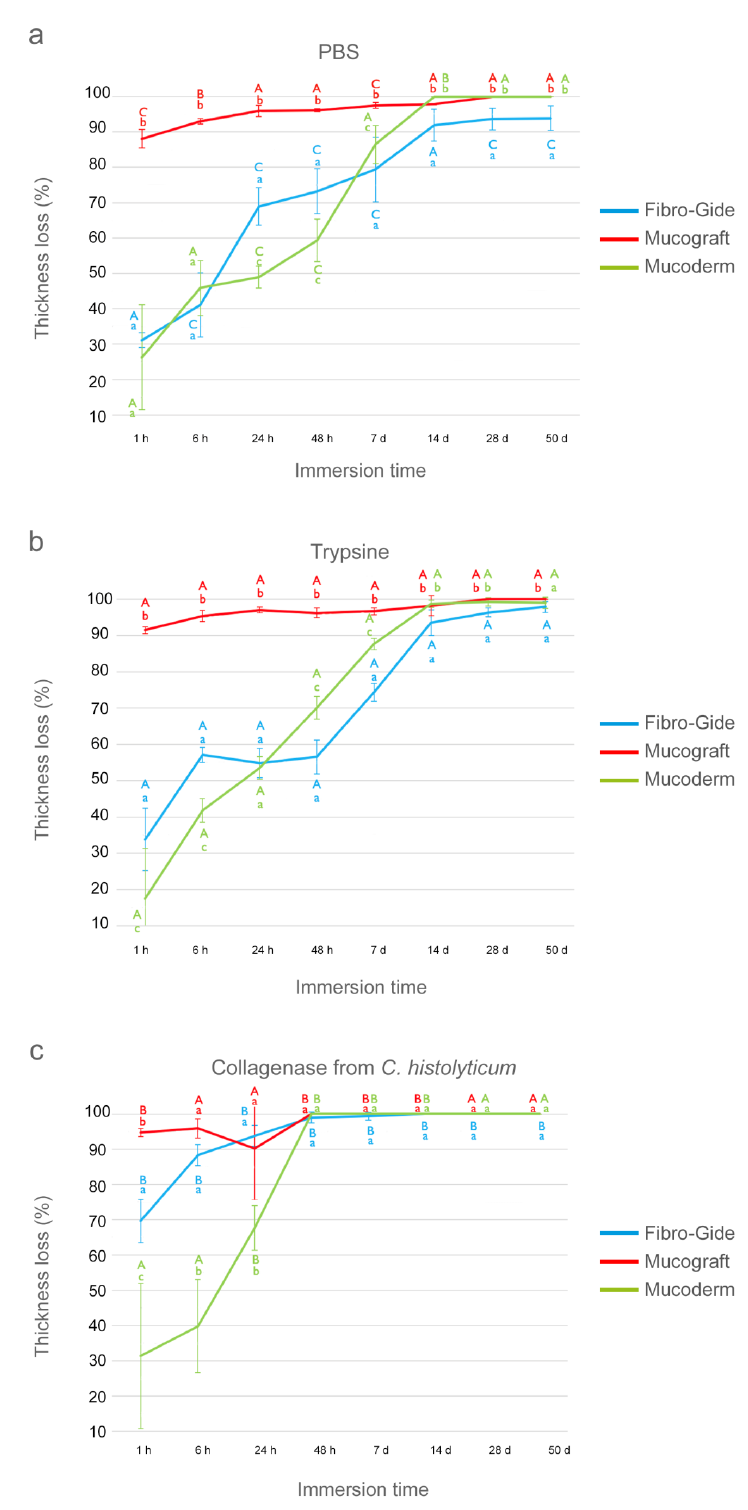
Figure 1. Percentage of thickness loss of the three matrices studied after immersion periods of up to 50 days in: ( a ) PBS, ( b ) trypsin and ( c ) C. histolyticum collagenase. Values shown are mean and standard deviation. Statistical significance is indicated with lower-case letters for differences between matrices over the same degradation test and with capital letters for differences between degradation tests within the same membrane. Student–Newman–Keuls tests were performed for multiple comparisons ( p <